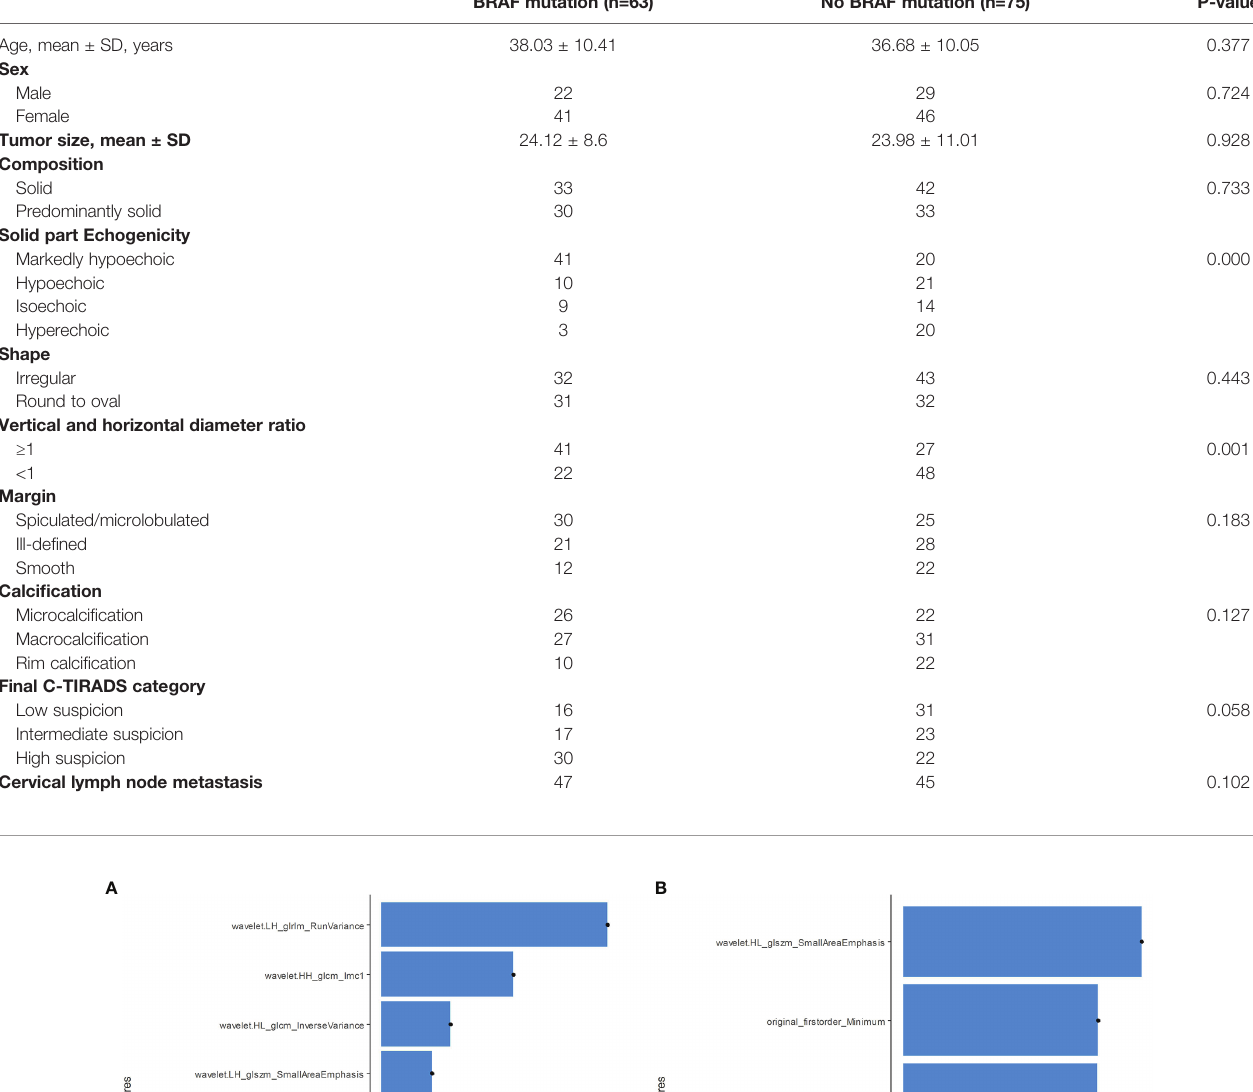
TABLE 2 | Relationship between BRAF mutations and US imaging characteristics through visual assessment of papillary thyroid carcinomas.